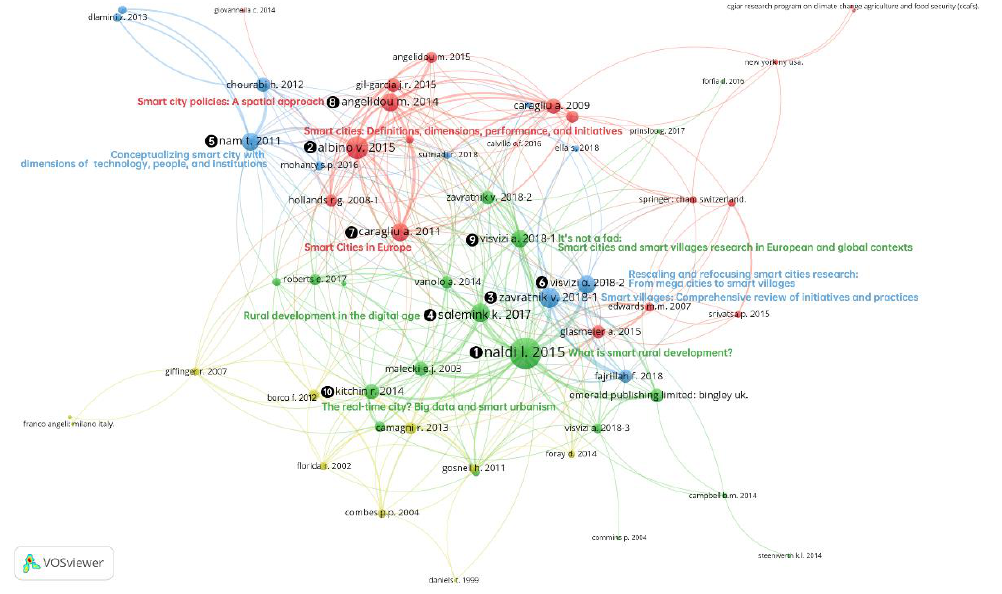
Figure 7. Co-citation network. n = 100 (isolated nodes removed). Minimum edges, 2; nodes, 59; clusters, 4; links, 315; total link strength, 710.